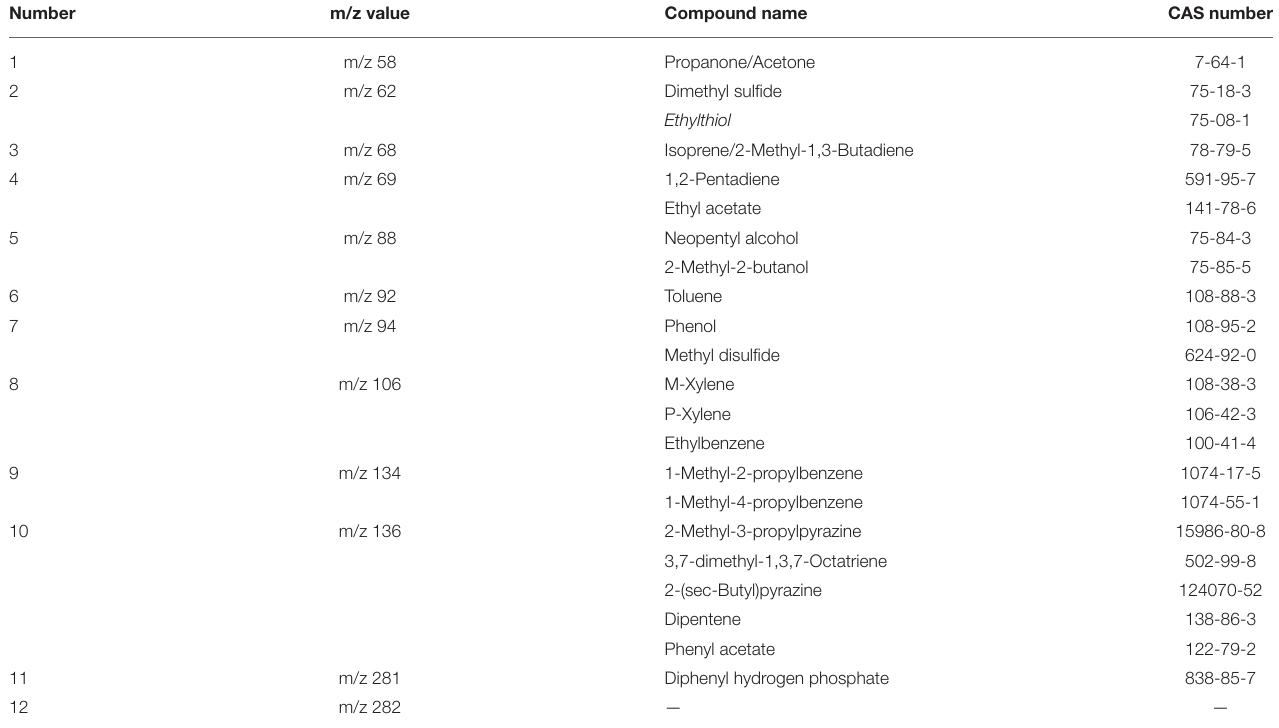
TABLE 2 | Reference compounds of characteristic VOCs of patients in the CPA group.